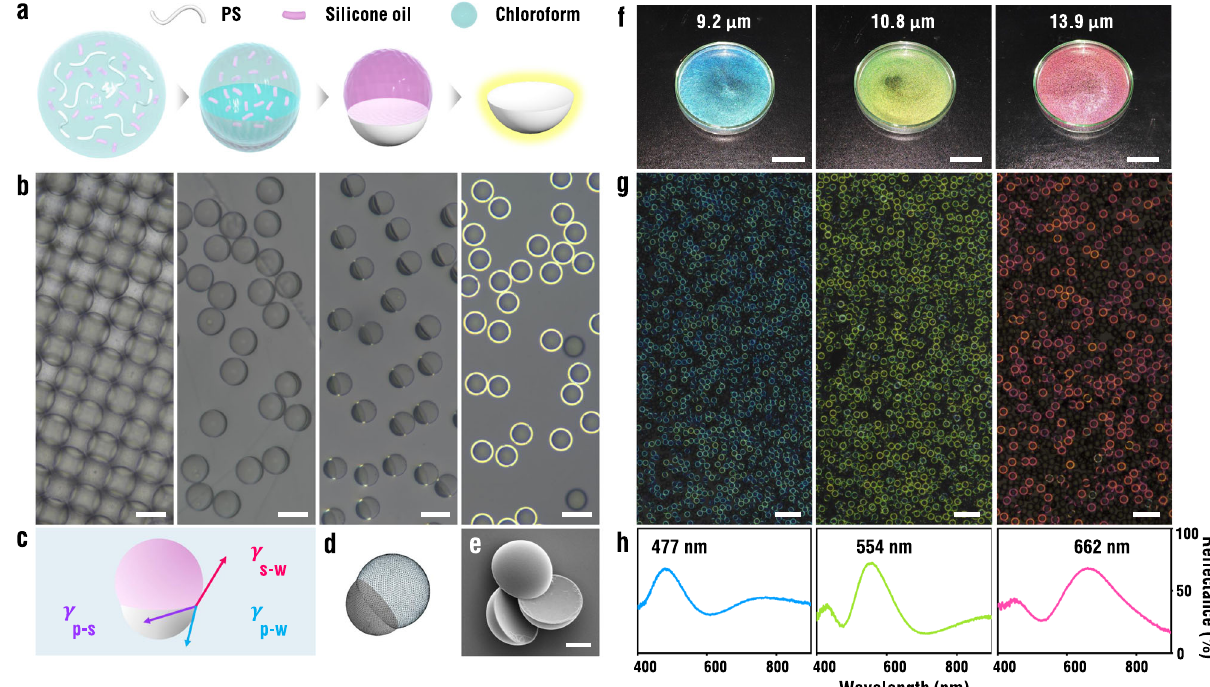
e Scanning electron microscope (SEM) image of the micro-crescents. Scale bar, 10 μ m. f Sets of photographs for the aqueous suspensions of micro-crescents with an average radius of 9.2, 10.8, and 13.9 μ m, respectively. Scale bar, 20mm. g, h Re fl ection optical micrographs and re fl ectance spectra corresponding to ( f ). Scale bar, 100 μ m. Source data for h is provided as a Source Data fi